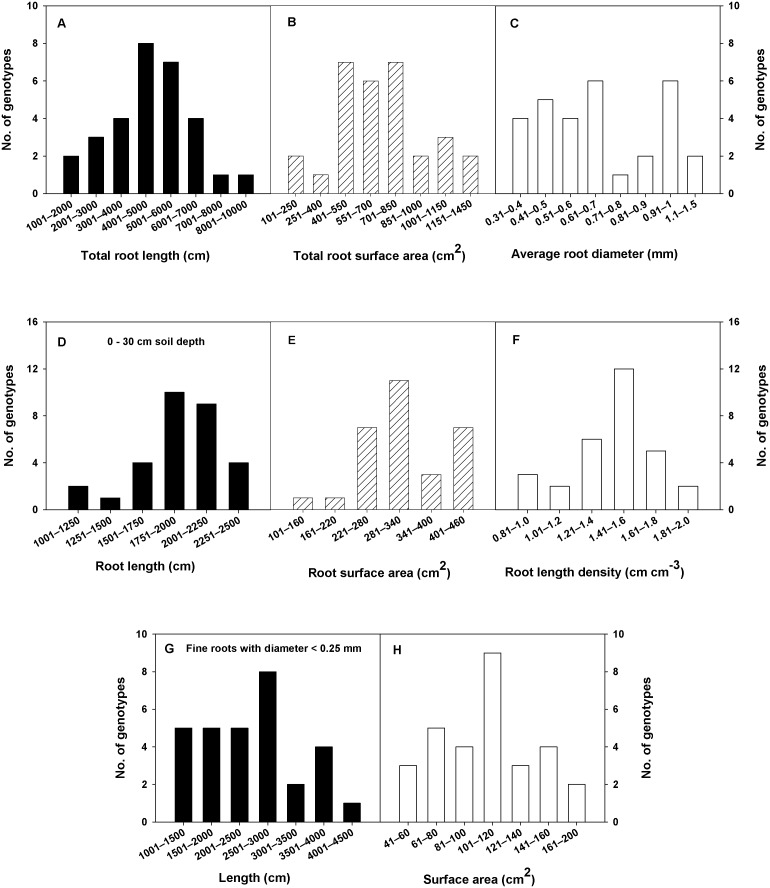
Distribution of major root traits within the subset of 30 spring wheat genotypes.The represented traits were measured for the 15 deepest and 15 smallest roots. Root length density is the ratio of root length in 0–30 cm depth of root system to the volume of the 30-cm section of the PVC column.